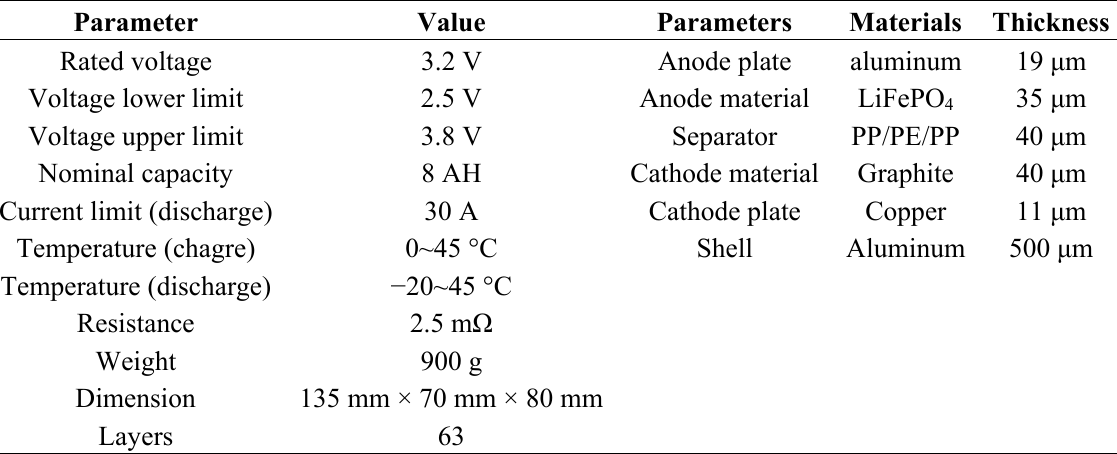
Table 1. Specific parameters of test